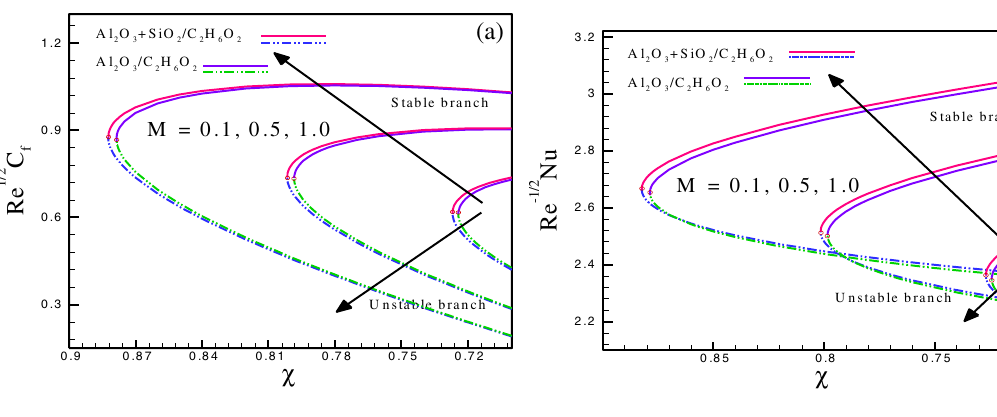
1 1 2 C f and Re − 2 Nu for different values of k p .